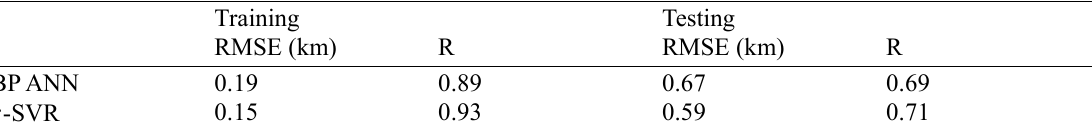
-SVR models for both 𝜀𝜀